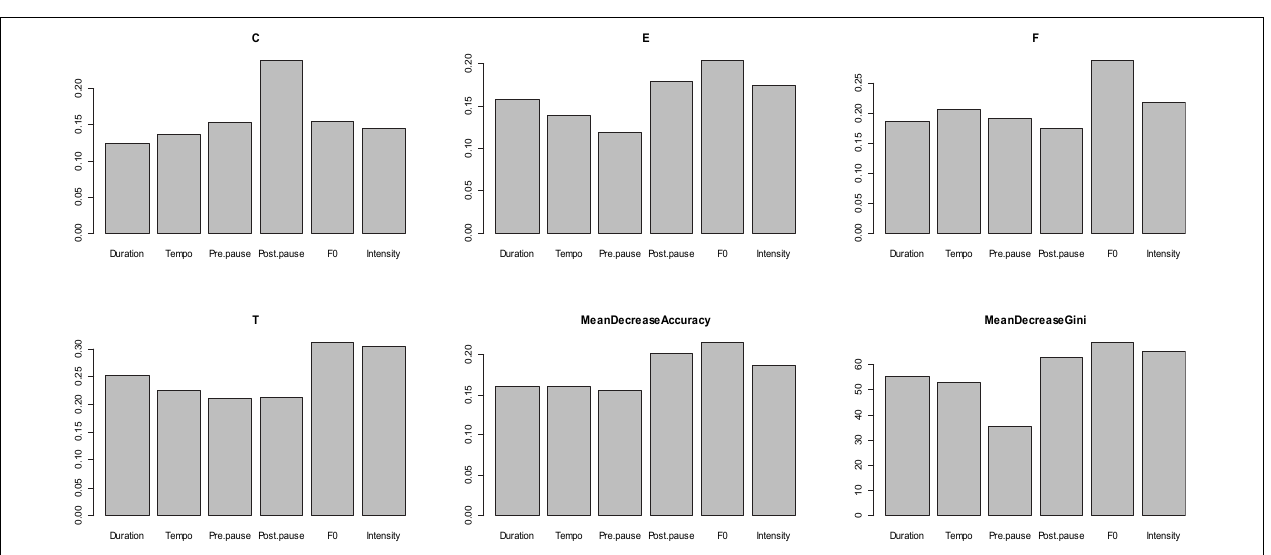
FIGURE 13 | Result of the variable importance in the classification